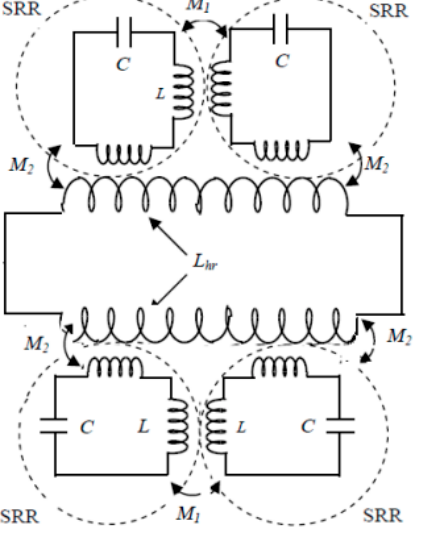
( b ) Figure 5. Reflection coefficient responses of the transmission line loaded with two SRRs ( a ) and photograph of the embroidered sample ( b ). In both cases, a deep rejection band can be observed. Figure 5 shows experimental S- parameter responses of the EM measurement of the embroidered transmission line loaded with two SRRs. The measured proposed design for two SRRs provided a stop band be- tween 3.8 GHz and 6.2 GHz with a − 35 dB rejection level; whereas, the one with four SRRs provided a stop band between 2.7 GHz and 4.7 GHz with more than − 45 dB. As can be observed, the higher the number of SRR stages, the deeper the level of rejection, exhibiting a well-defined stop bandwidth. 3. Conclusions In this work, the effect of an embroidered textile MTM stop band filter, based on the combination of SRRs and microstrip technology, was simulated and measured. The pro- posed design was a fully embroidered conductive thread transmission line, loaded with